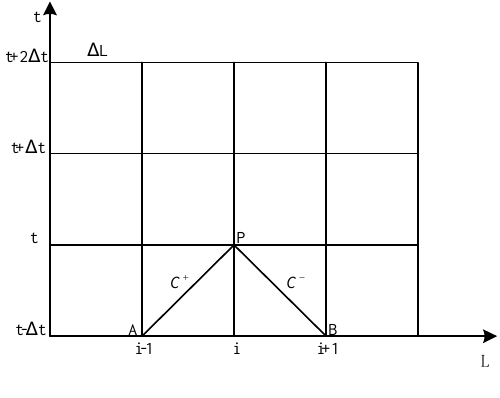
Figure 2. Difference grid obtained by MOC.